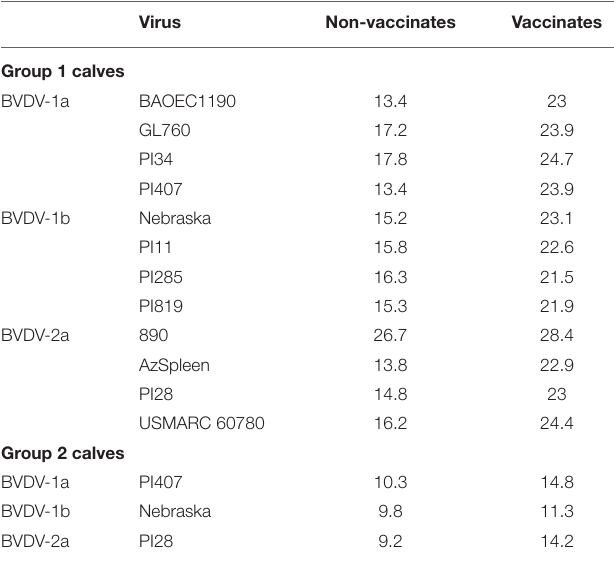
TABLE 2 | Average total frequency of CD25 + PBMCs for vaccinated and un-vaccinated calves in Groups 1 and 2 after stimulation with BVDV 1a, 1b, and 2a